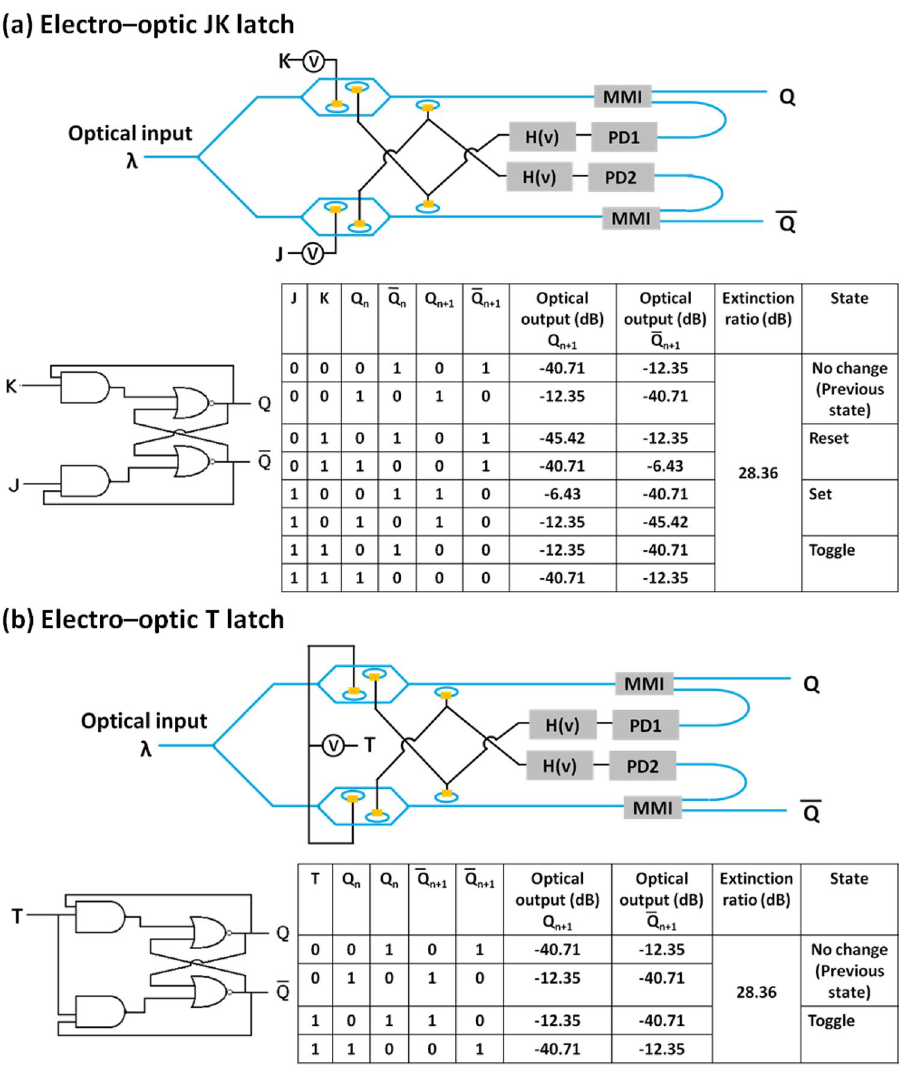
Figure 8. Electro-optic configurations, graphical symbol, and truth table of a: ( a ) JK latch circuit, and ( b ) T latch